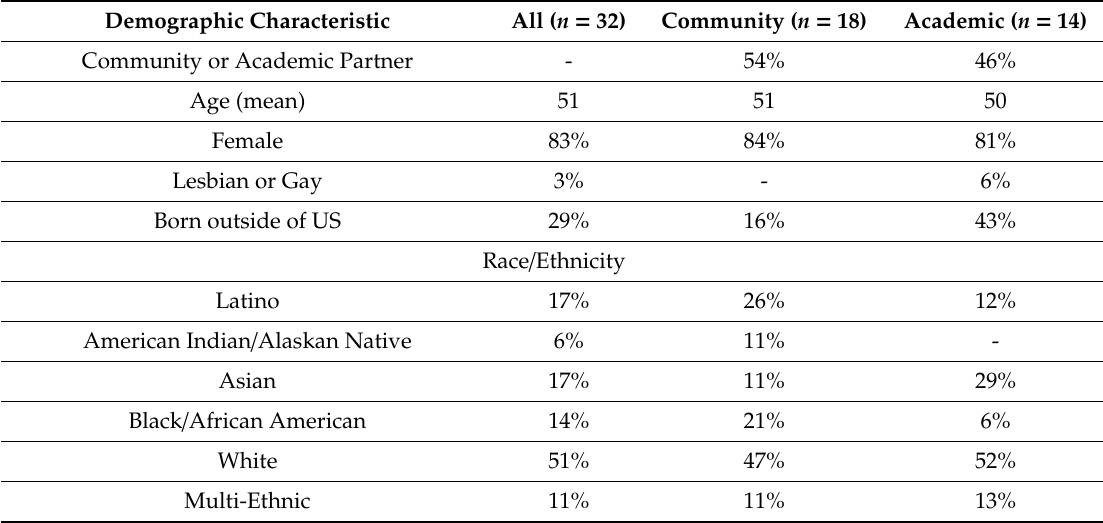
Table 1. Demographic characteristics of CRIBS participants ( N =